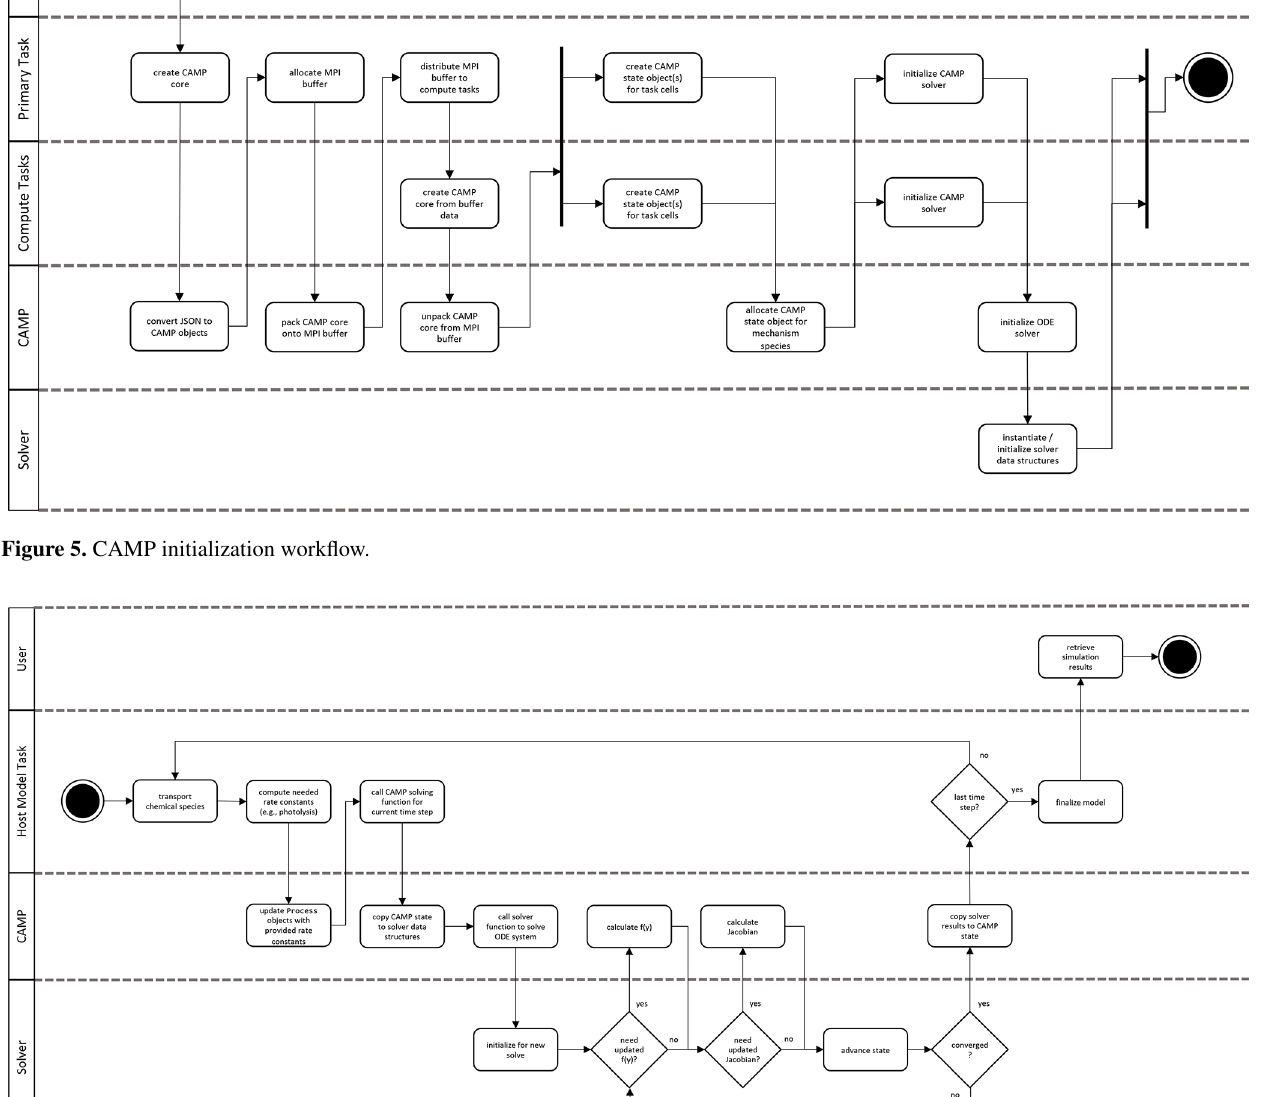
Figure 6. CAMP runtime workflow. Note that the CAMP state refers to the state of the coupled gas–aerosol system comprising temperature, pressure, gas-phase chemical species mixing ratios, and the representation-specific state of the aerosol system. For the single-particle repre- sentation, the aerosol state comprises the condensed species mass concentrations and the number of simulated particles the computational particle represents. For the modal and sectional representation, the aerosol state comprises the condensed species mass concentrations